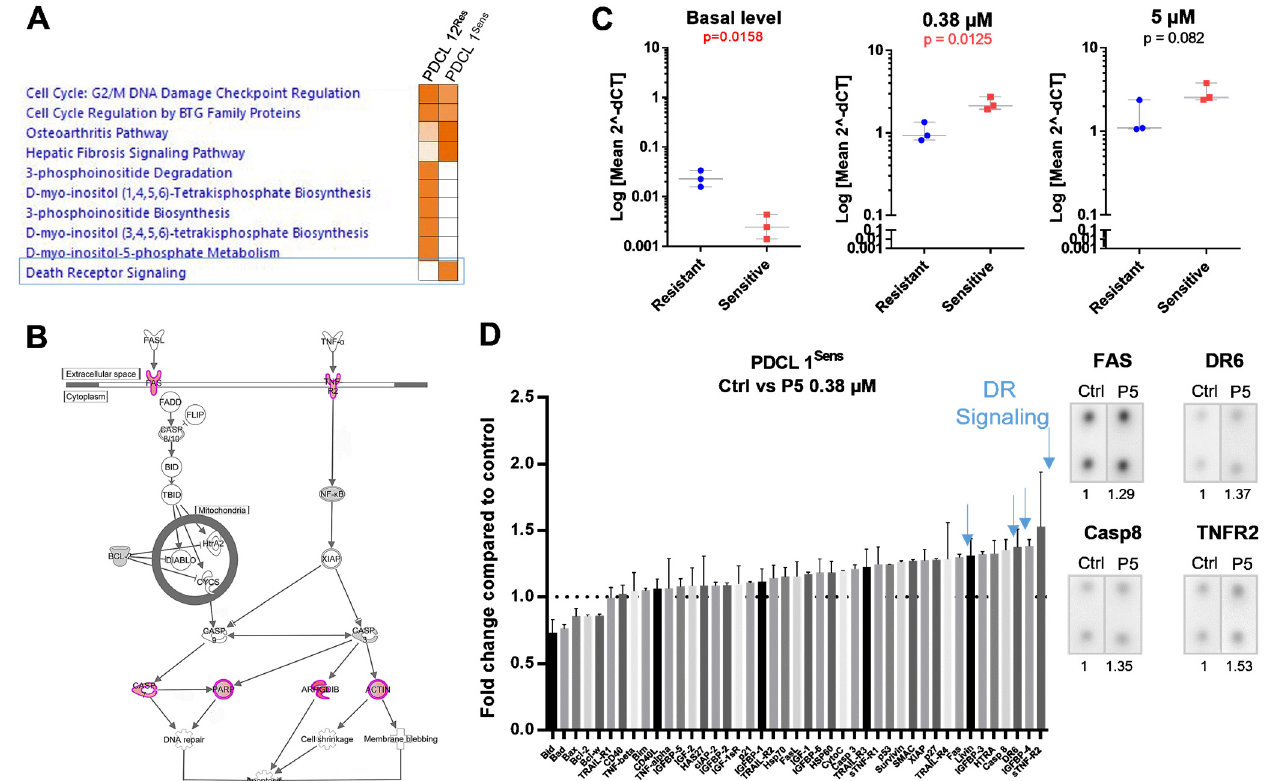
Figure 4. Death Receptor signaling pathway and FAS expression dynamics predict the response to compound P5 . ( A ) Orange intensity is proportional to the level of pathway activation (IPA z-scores). The Death Receptor signaling pathway is predicted to be activated ( p -value of 0.000127 and z-score of 2.449) in PDCL 1 Sens in response to P5 , unlike in PDCL Res (incubation for 24 h at their IC 30–50 values, 0.35 and 5 µM, respectively). ( B ) Representation of the Death Receptor signaling pathway showing in red the genes that were overexpressed in PDCL 1 Sens in response to P5 . ( C ) FAS expression as measured by RT-qPCR in three PDCL Res (PDCLs 12, 13, and 4) and PDCL Sens (PDCLs 1, 5, and 6) at the basal level or in response to 0.38 or 5 µM P5 . ( D ) Apoptosis protein array of PDCL 1 Sens in response to P5 (compared to untreated–Ctrl-cells). Representative images of dot blots of proteins involved in the Death Receptor (DR) signaling pathway for the control and P5 -treated PDCL 1 Sens conditions are shown.